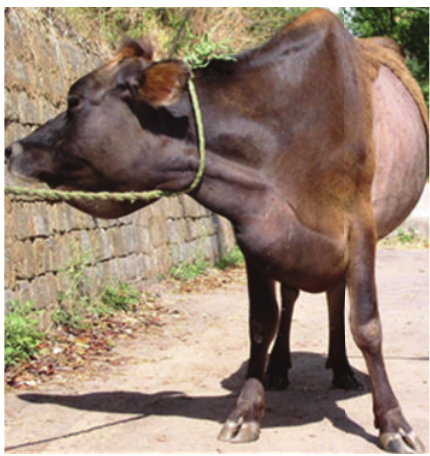
Figure 1: Ventral edema and jugular venous distention in a Jersey cross-bred cow with pericarditis.